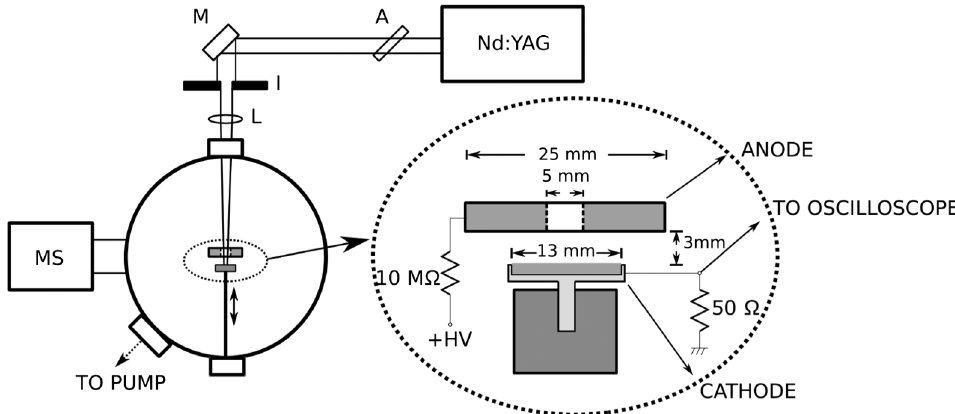
FIG. 1. Schematic of the photodiode cell used for measuring the QE of the films. M: mirror; A: attenuator; I: iris; L: lens; MS: mass